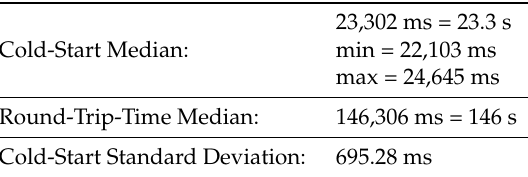
Table 2. Descriptive statistics versions.